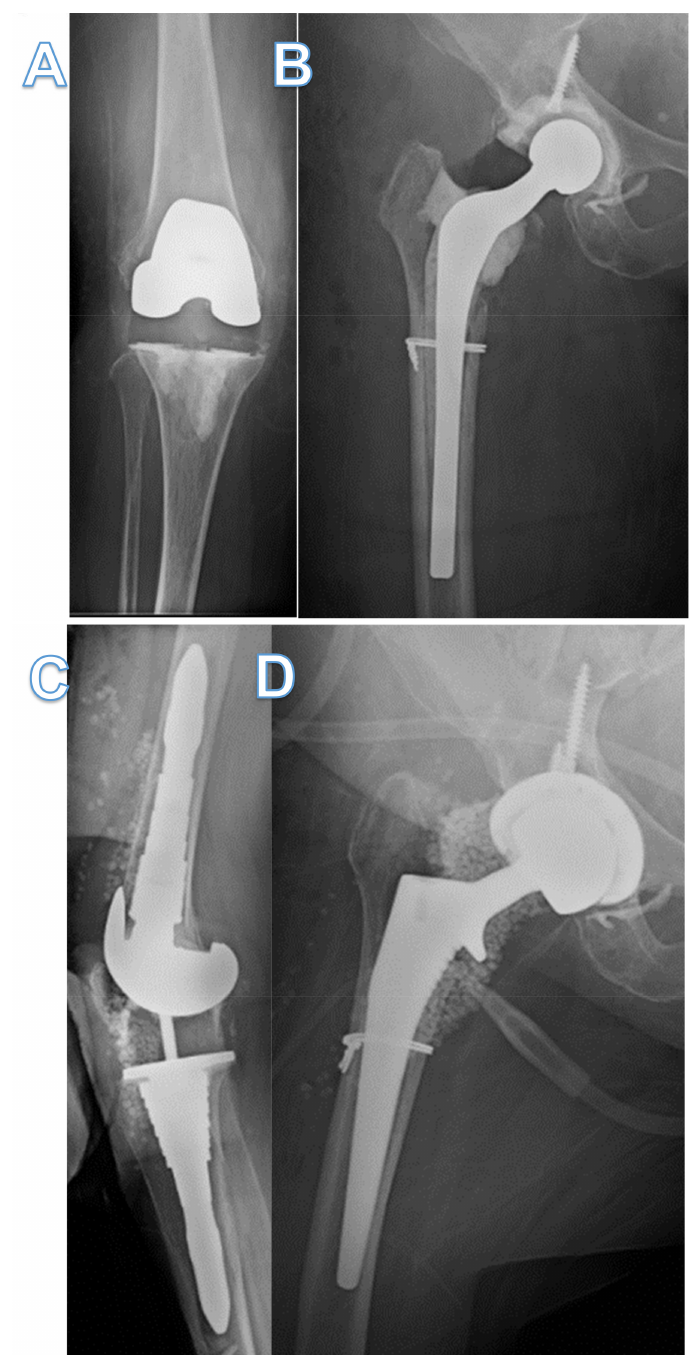
Figure 1. X-ray of knee and hip before and after bacteriophage therapy. ( A , B ) X-ray anterior-posterior view of right knee and hip showing temporary antibiotic-coated knee prosthetic and Prostalac hip spacer with residual cerclage wire and screw. ( C , D ) X-ray lateral view knee and anterior-posterior view hip showing total knee and hip arthroplasties implanted after bacteriophage therapy and subsequent proven sterility of the joints. Retained cerclage wire still